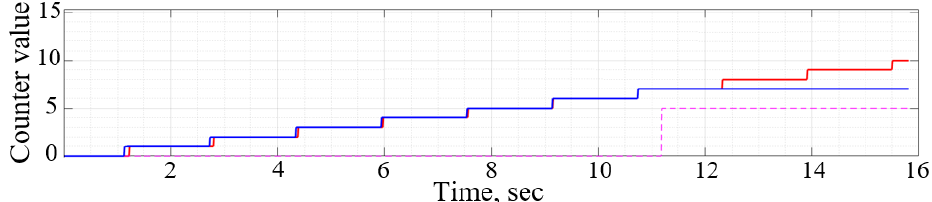
Figure 15. An example of the operation of the skew detection algorithm with a counter: blue is the value of the counter that controls the readings of the IPS opposite rail 1, red is the value of the counter that controls the readings of the IPS opposite rail 2, and pink is the time the failure was introduced into the system.